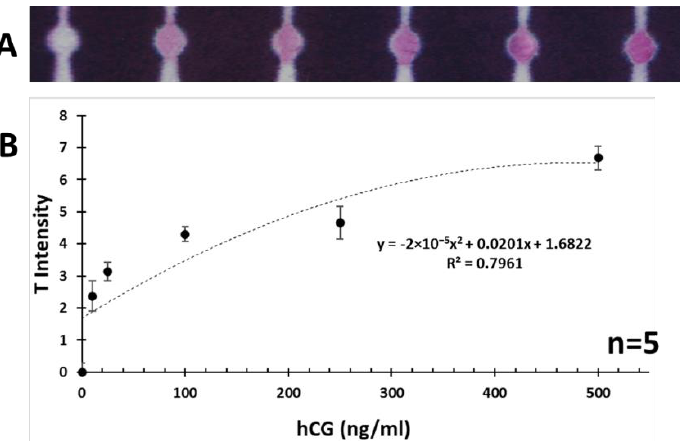
Figure 6. ( A ) Photographs of µ PADs indicating the obtained colorimetric signals at the T zone after introducing 50 µ L of standard hCG solutions in the range (0, 10, 25, 100, 250, 500 ng/mL). ( B ) Corresponding response calibration curve was acquired from quantitative image analysis of tested µ PADs. A polynomial fitting model was used. The error bars represent the standard deviations corresponding to the average values.